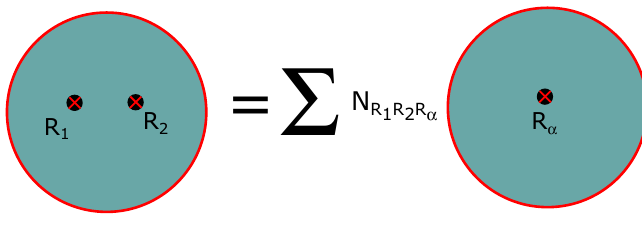
Figure 12 . Fusing two (cid:8)-punctures into a single